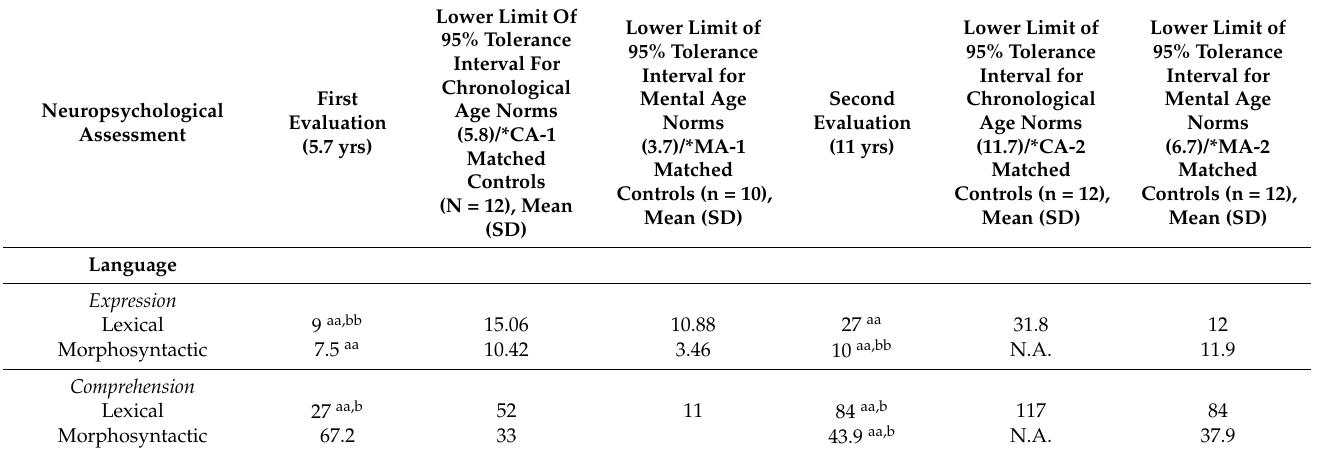
Table 1. Raw scores on neuropsychological tests obtained by the girl at 5.7 years of age and 11 years of age. For each test (depending on the availability of normative data), the lower limit of the 95% tolerance interval for the normative population, or mean scores and standard deviations (*) of chronological-age (CA-1-matched) and mental-age (MA-1-matched) matched control groups at first evaluation and chronological-age (CA-2-matched) and mental-age (MA-2-matched) matched control groups at second evaluation, are reported. Letters “a”, “aa”, “b” and “bb” indicate if the girl scored below average.